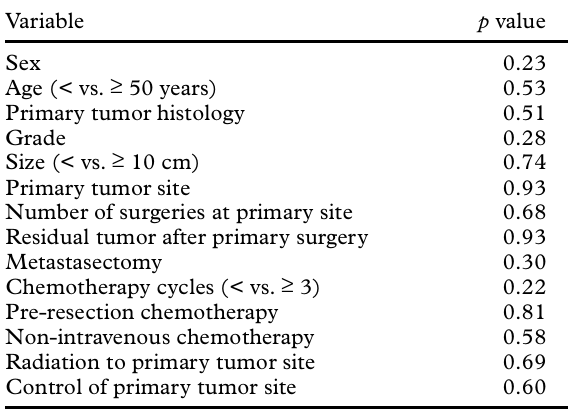
Table 4 . Effect of various factors on the overall survival in